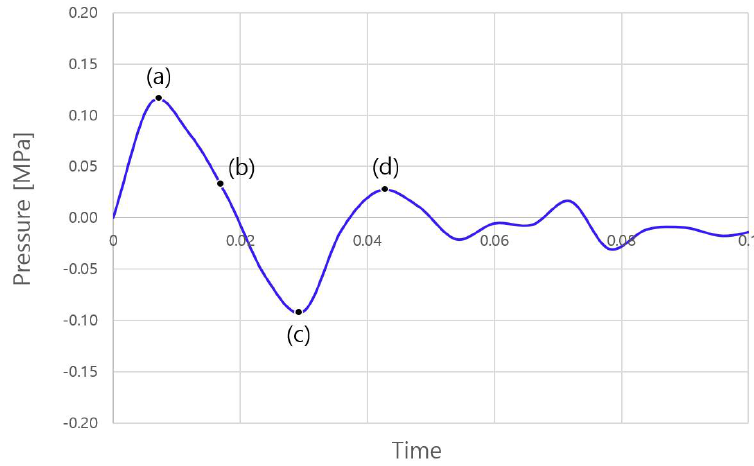
Figure 9. Pressure time history for center of bottom plate ( h : 2 m; t : 3 mm).